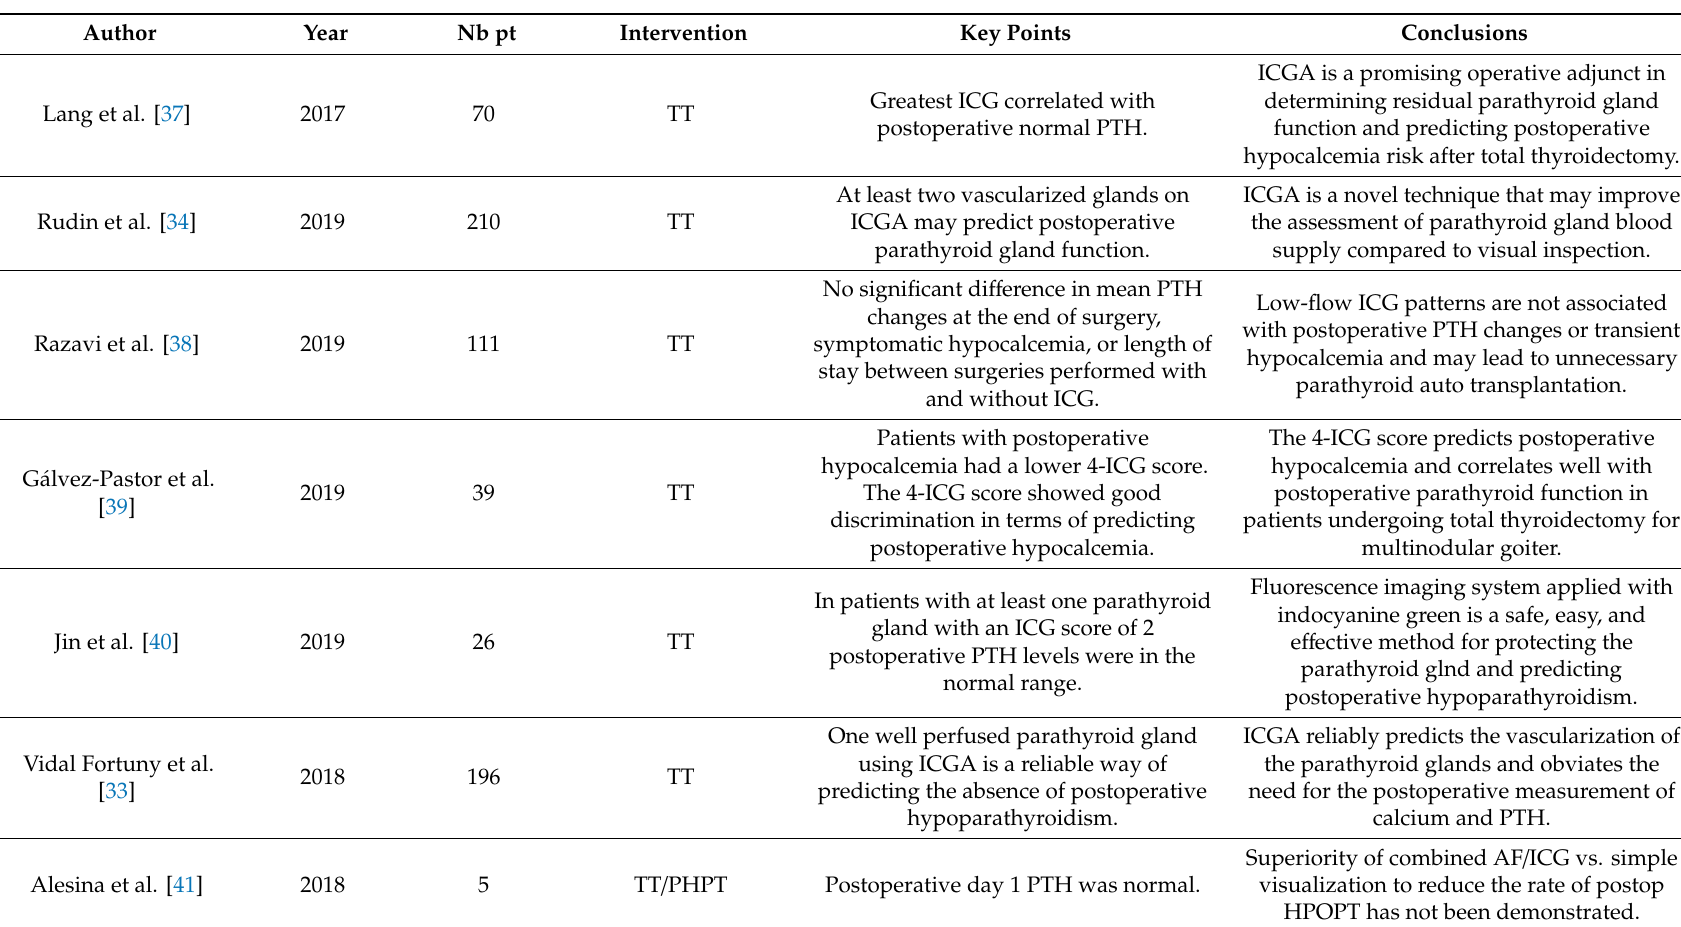
Table 2. Recent studies that evaluate the benefits of indocyanine green angiography (ICGA) in thyroid